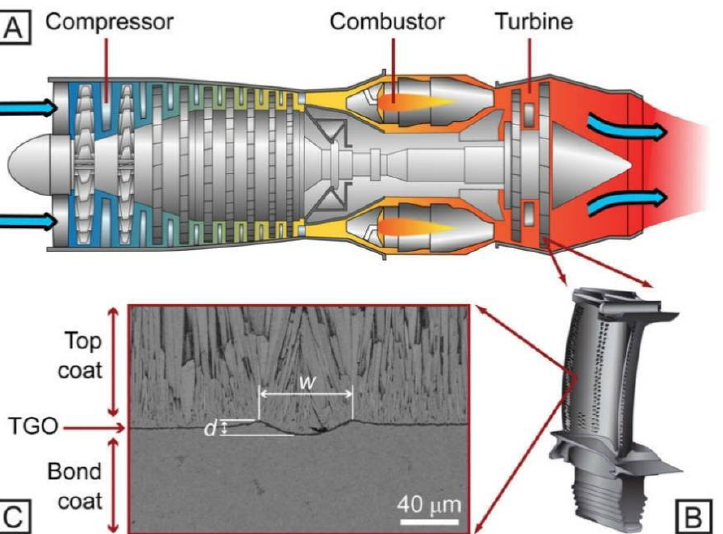
Figure 1. ( A ) Schematic diagram of a gas turbine, ( B ) Blade of the turbine and ( C ) cross-section TBC system [6].